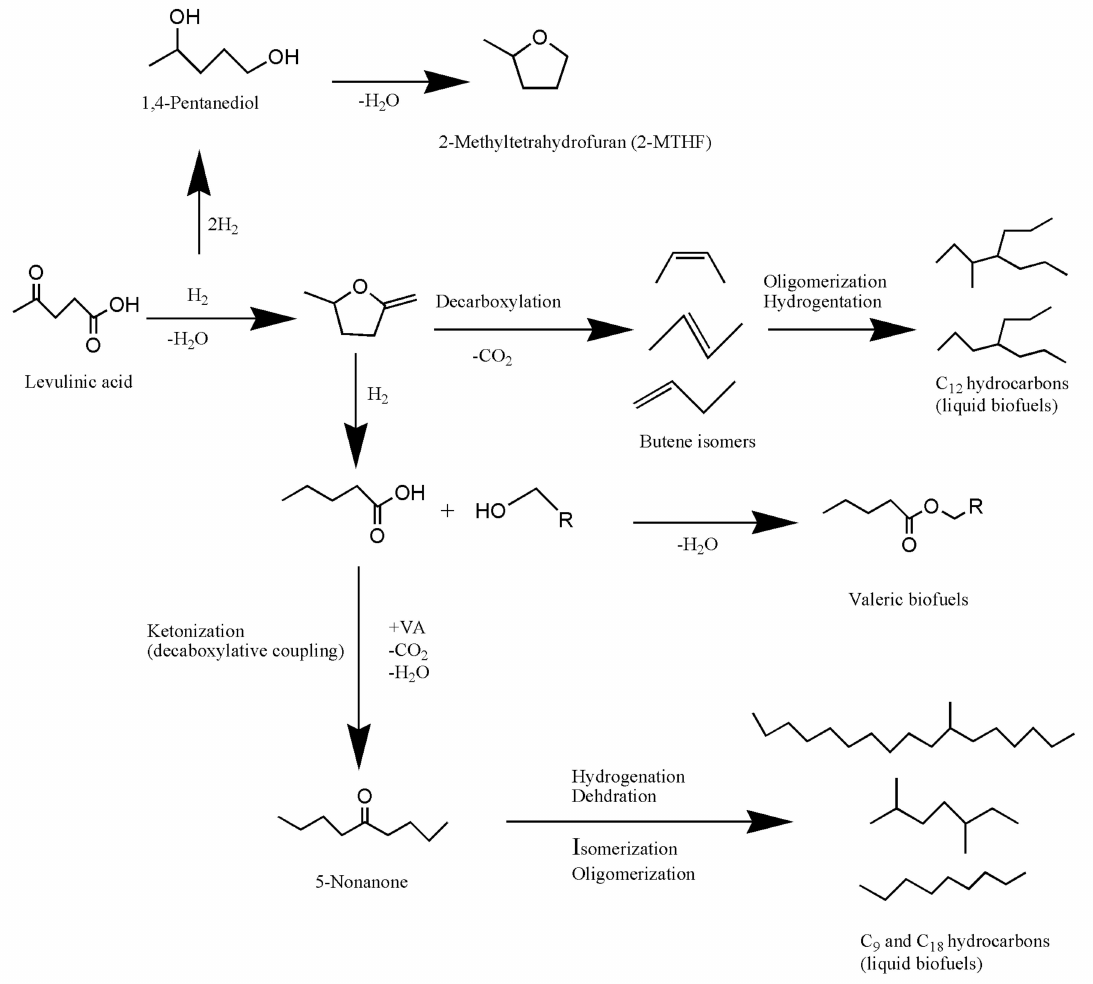
Figure 2. Different routes for the production of chemicals, biofuels, and solvents via catalytic hydrogenation of